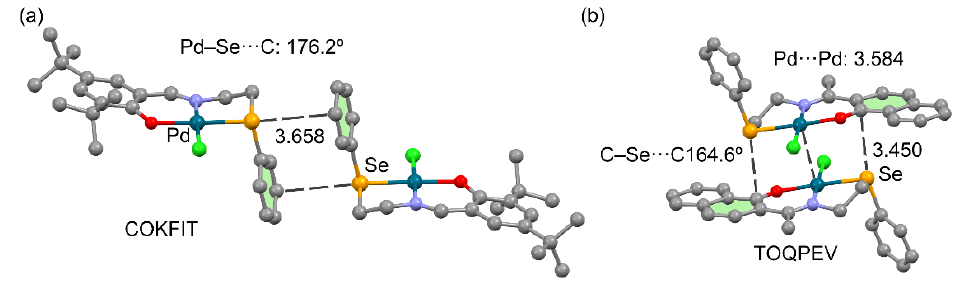
Figure 8. Partial views of the X-ray structures of refcodes COKFIT ( a ) and TOQPEV ( b ). Distances in Å. H-atoms omitted for